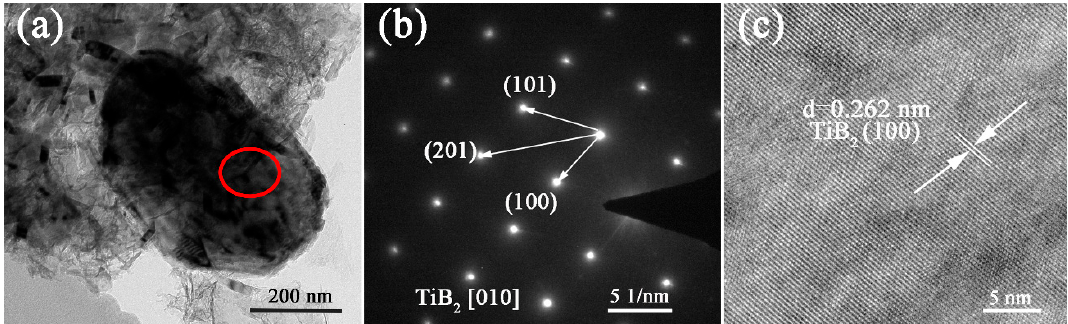
Figure 6. ( a ) Low-magnification TEM image and ( b ) SAED pattern of a representative TiB 2 microplatelet in the sample prepared via MSM-BCTR at 1200 °C for 20 min, and ( c ) high-resolution TEM image taken in the area defined by the red circle in ( a ).